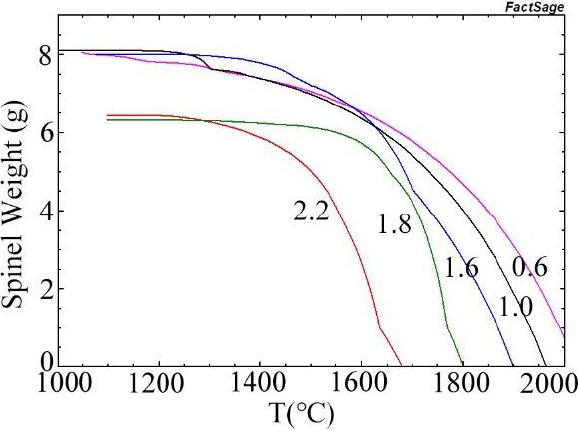
Figure 3: Residual liquid phase changed with the basicity during the solidification